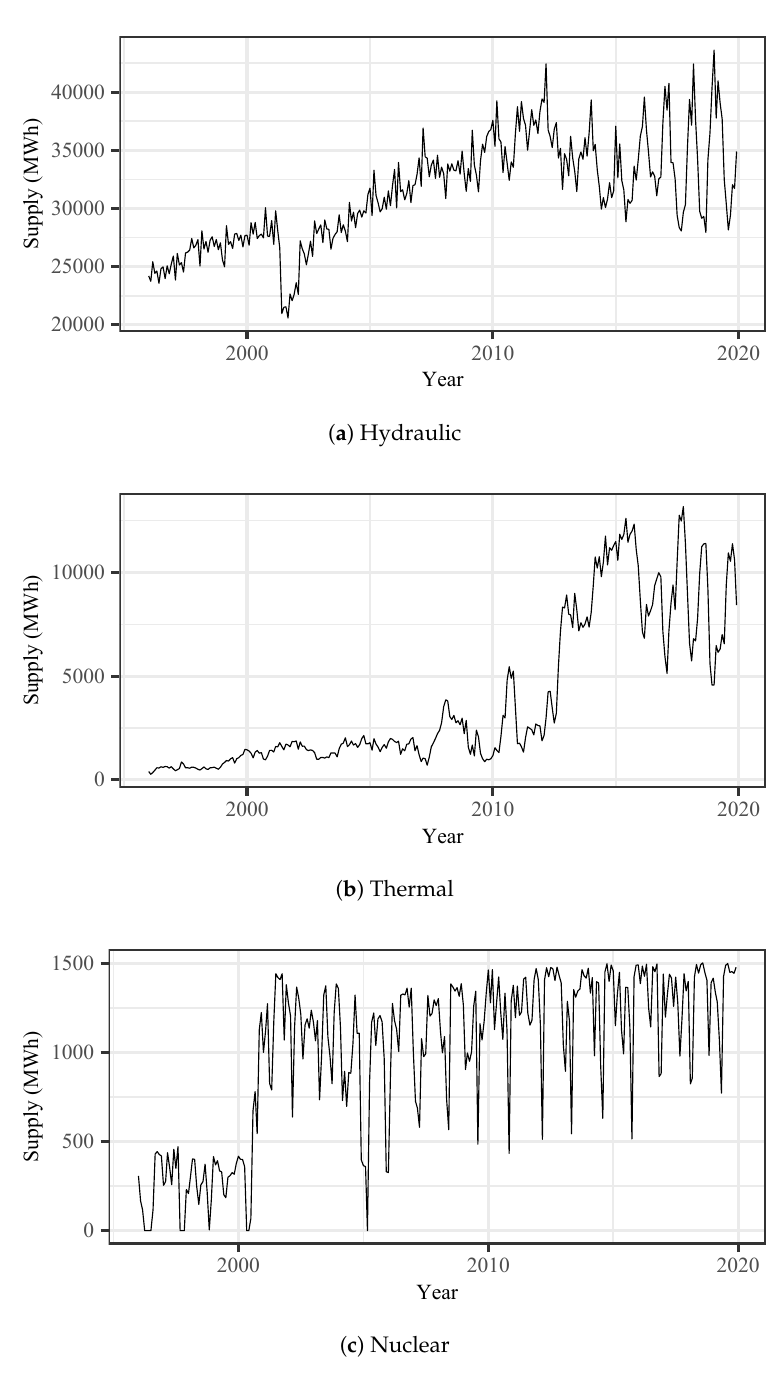
Figure 3. Brazilian electricity